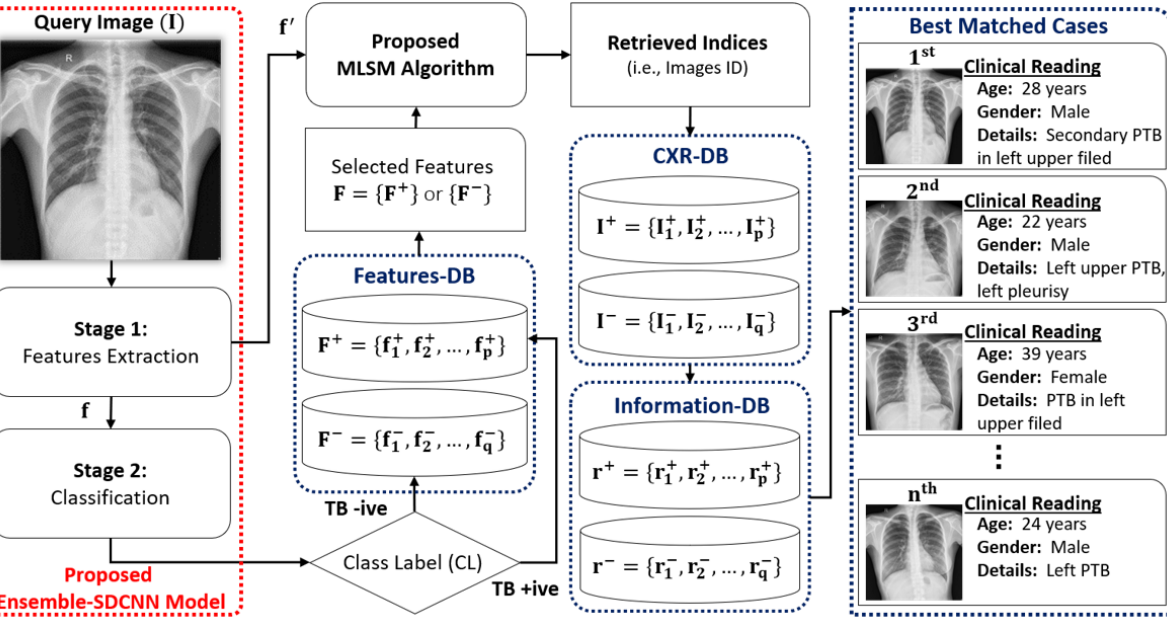
Figure 1. Comprehensive flow diagram of the proposed classification and retrieval framework. In the first stage, the given input CXR image is categorized as either TB positive or TB negative. In the second stage, the n best relevant cases are retrieved from the previous database based on our proposed MLSM algorithm. The parameter n is a user given input and controls the total number of retrieved cases from the previous record related to a current medical condition. CXR: chest radiograph; DB: database; MLSM: multilevel similarity measure; SDCNN: shallow–deepCNN; TB: